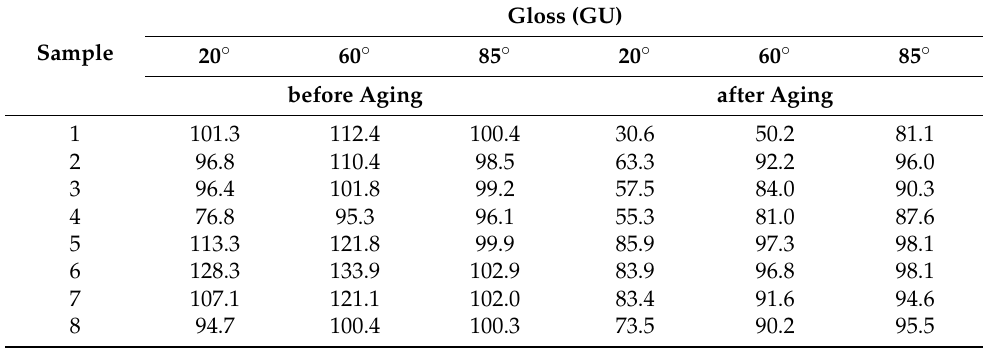
Table 4. Gloss measurement data of the studied composites before and after the accelerated aging